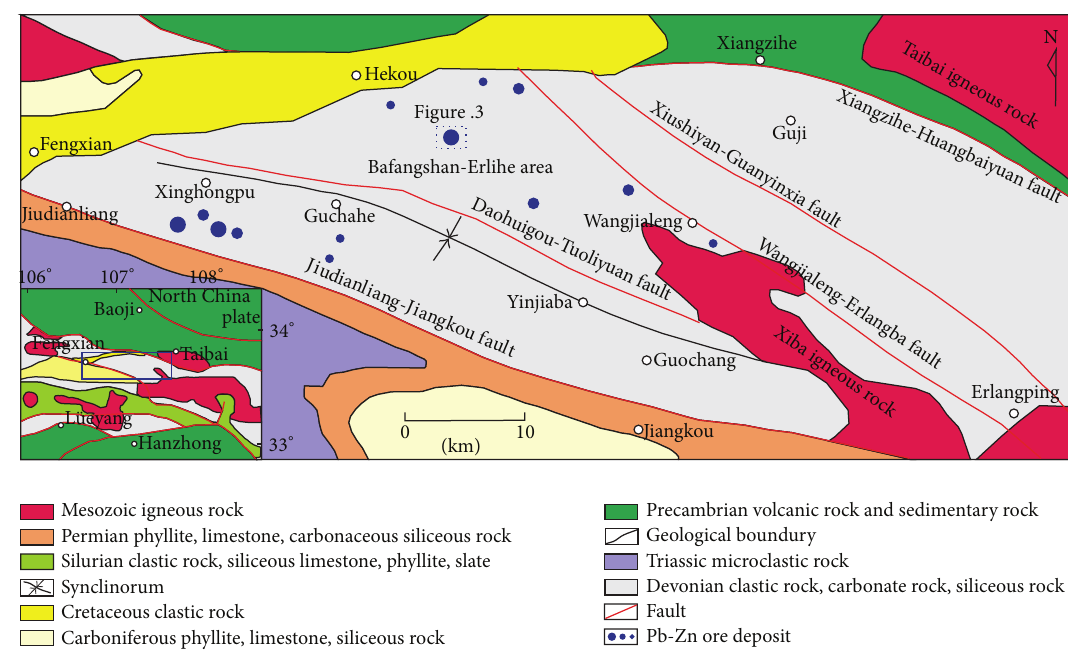
∼ Late Silurian and Early Devonian ∼ Late Triassic [26].